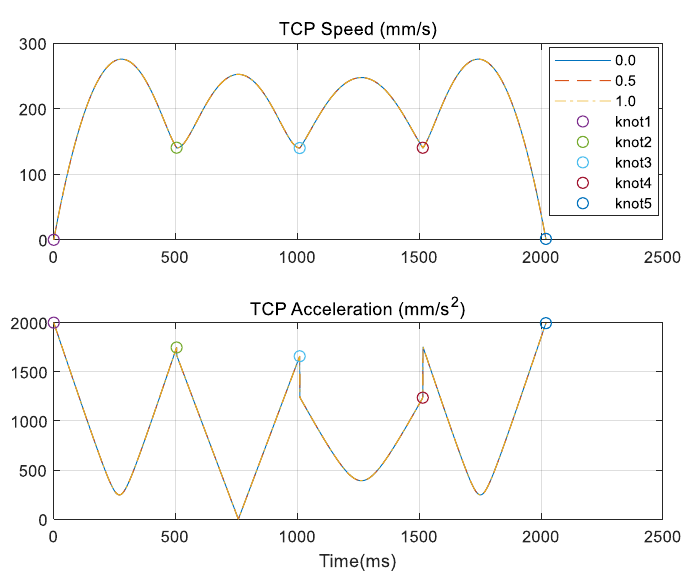
Figure 7. Velocity and acceleration according to 𝛽 in the task #1. TCP—Tool Center Point.